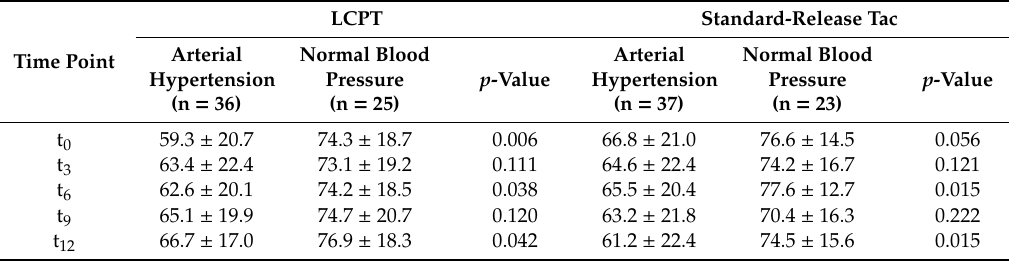
Table 6. Glomerular filtration rate (eGFR; mL / min / 1.73 m 2 ) in patients with and without arterial